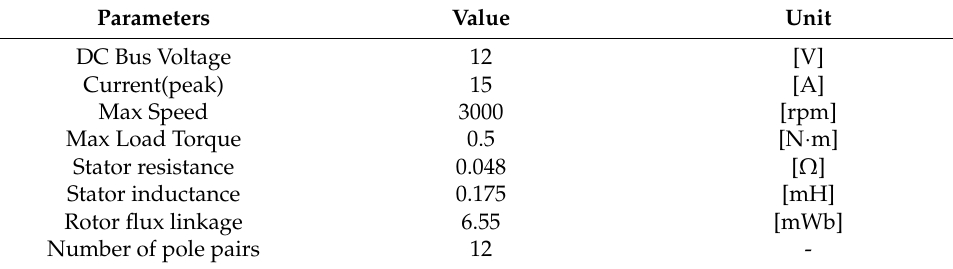
Table 2. Parameters and specifications of an AC drive